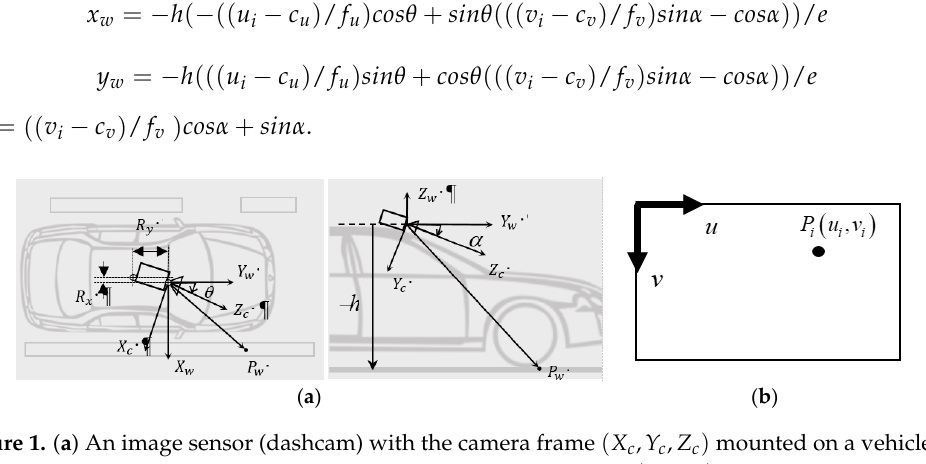
where (𝑓 (cid:3048) ,𝑓 (cid:3049) ) and (𝑐 (cid:3048) ,𝑐 (cid:3049) ) are the focal length and the image sensor’s optical center, respectively, and 𝑑 = 𝑥 (cid:3050) 𝑐𝑜𝑠𝛼 𝑠𝑖𝑛𝜃 + 𝑦 (cid:3050) 𝑐𝑜𝑠𝛼 𝑐𝑜𝑠𝜃 + ℎ 𝑠𝑖𝑛𝛼. The inverse perspective mapping from the image plane to the ground plane can be obtained by 𝑥 (cid:3050) = −ℎ(−((𝑢 (cid:3036) − 𝑐 (cid:3048) )/𝑓 (cid:3048) )𝑐𝑜𝑠𝜃 + 𝑠𝑖𝑛𝜃(((𝑣 (cid:3036) − 𝑐 (cid:3049) )/𝑓 (cid:3049) )𝑠𝑖𝑛𝛼 − 𝑐𝑜𝑠𝛼))/𝑒